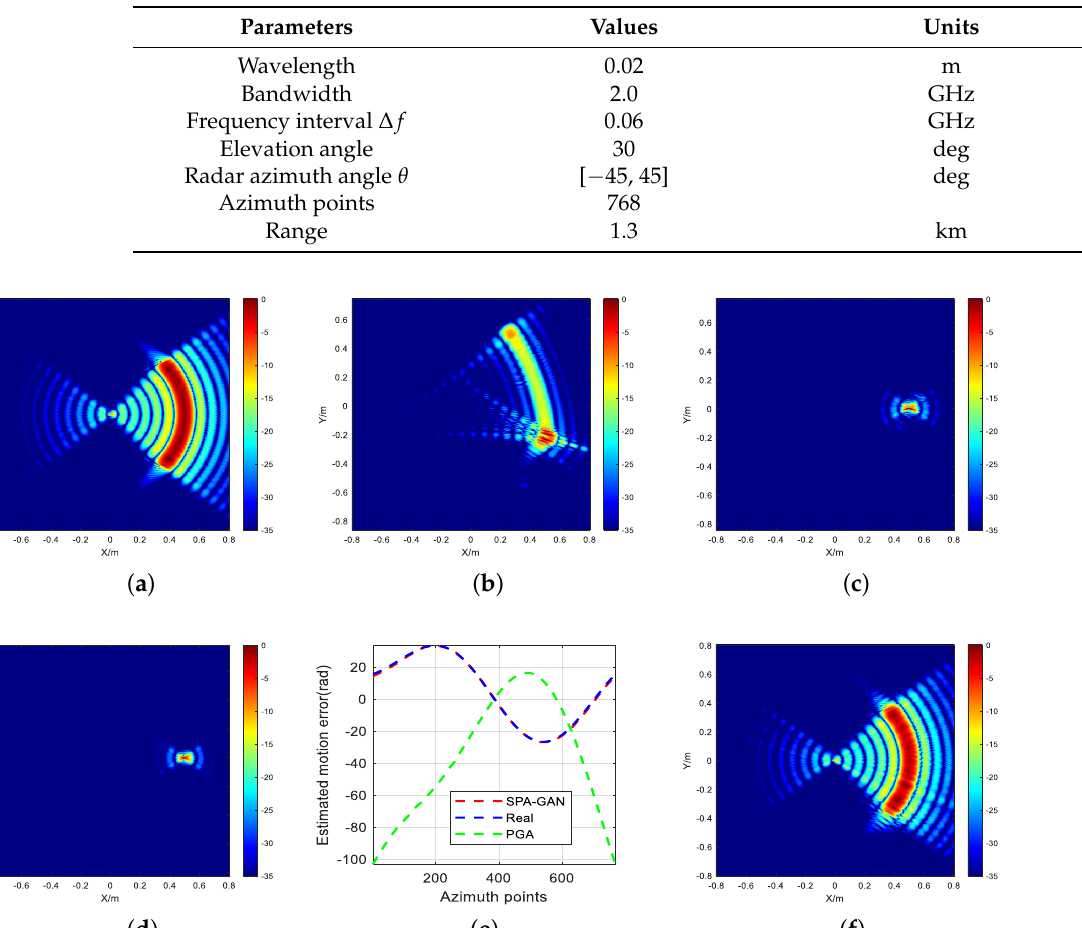
Table 1. Simulation parameters.